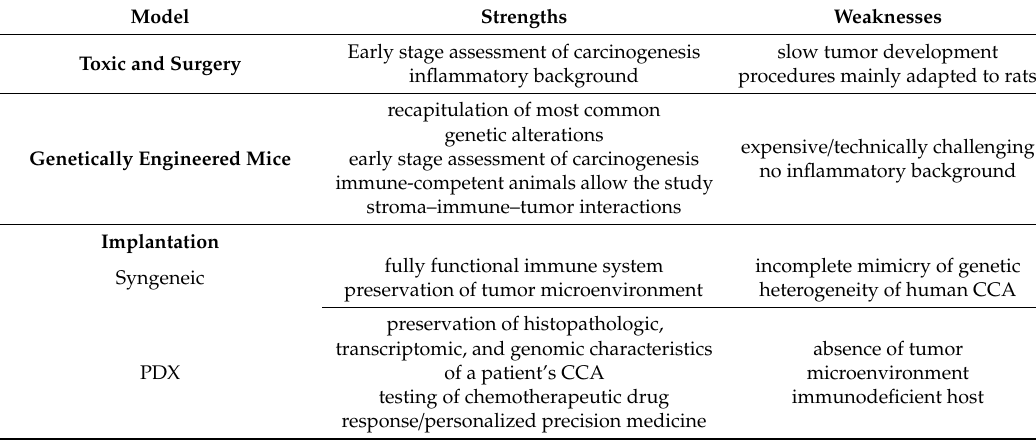
Table 1. Strengths and weaknesses of the main rodent models of